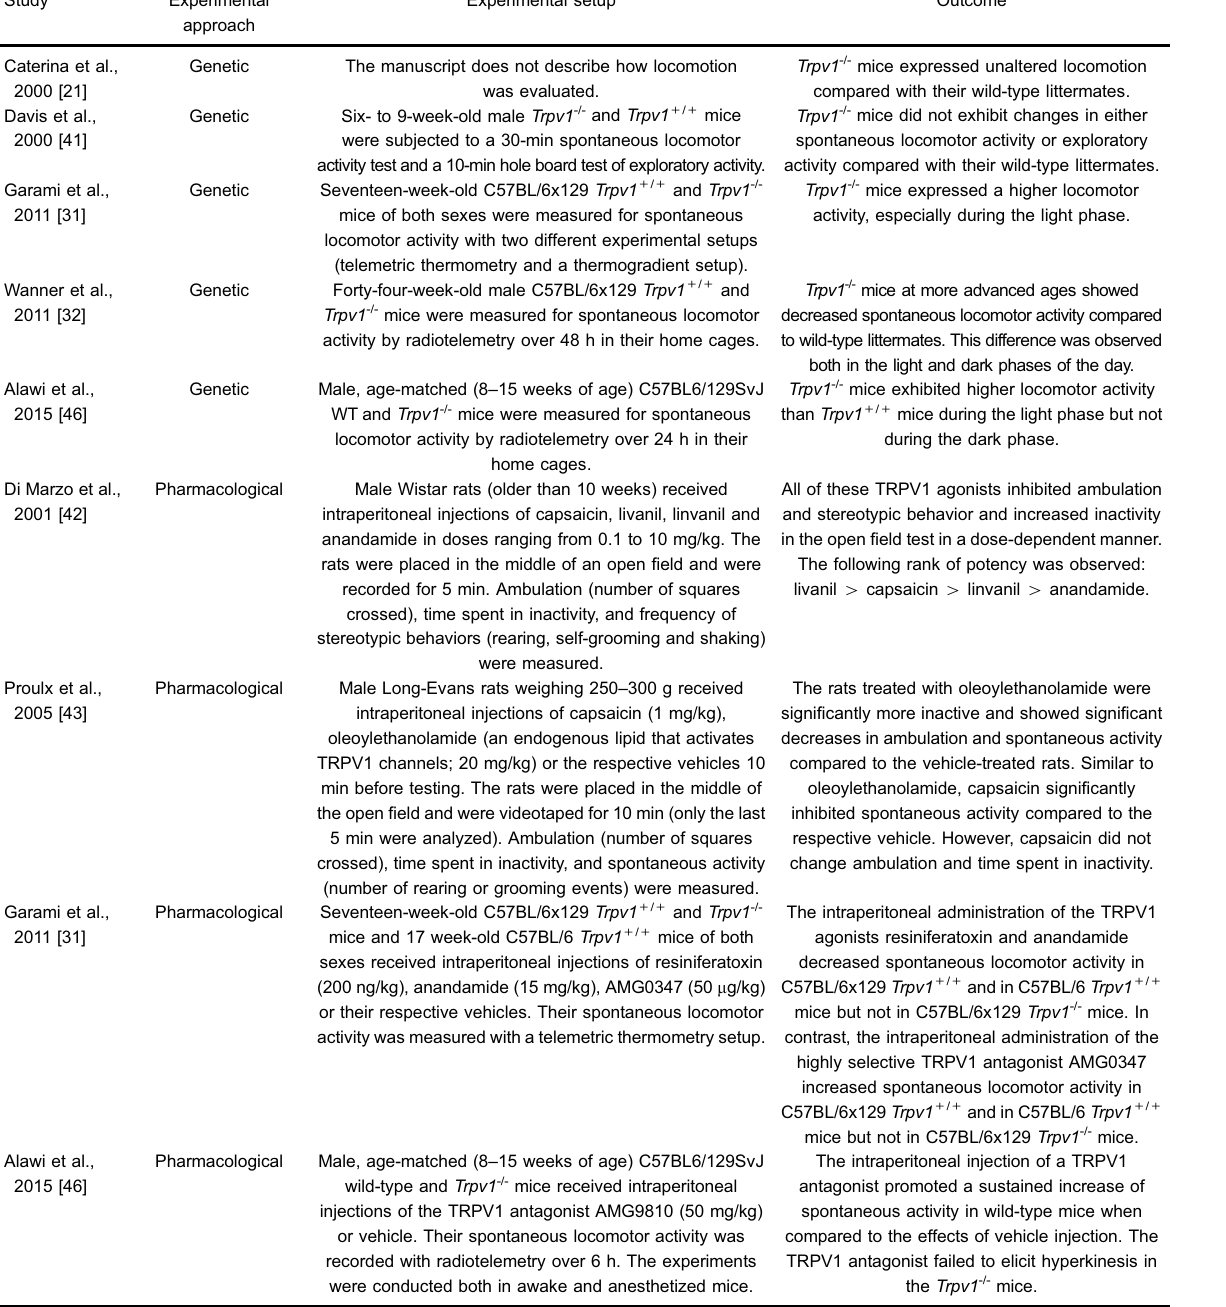
Table 1. Association between the transient receptor potential vanilloid type 1 (TRPV1) channel and spontaneous locomotor